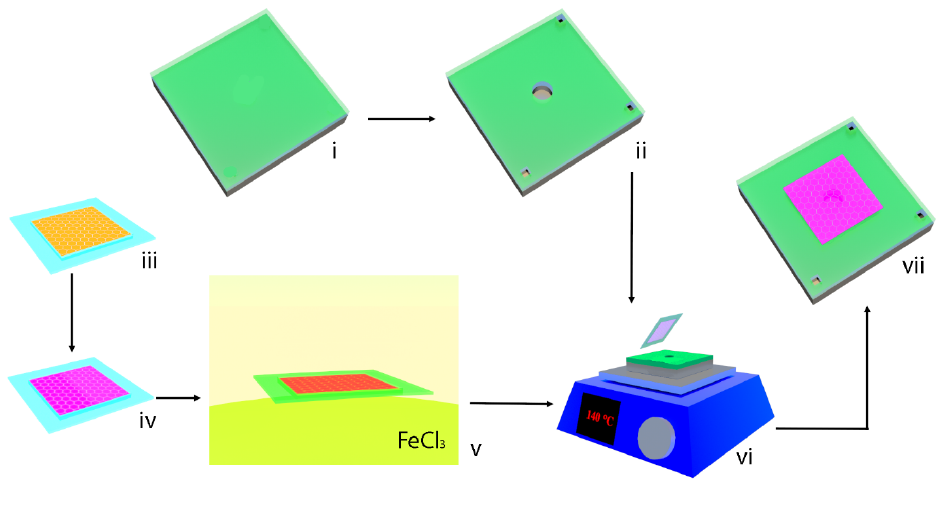
Figure 2. The fabrication schematic of the graphene/PMMA closed cavity ultrasonic